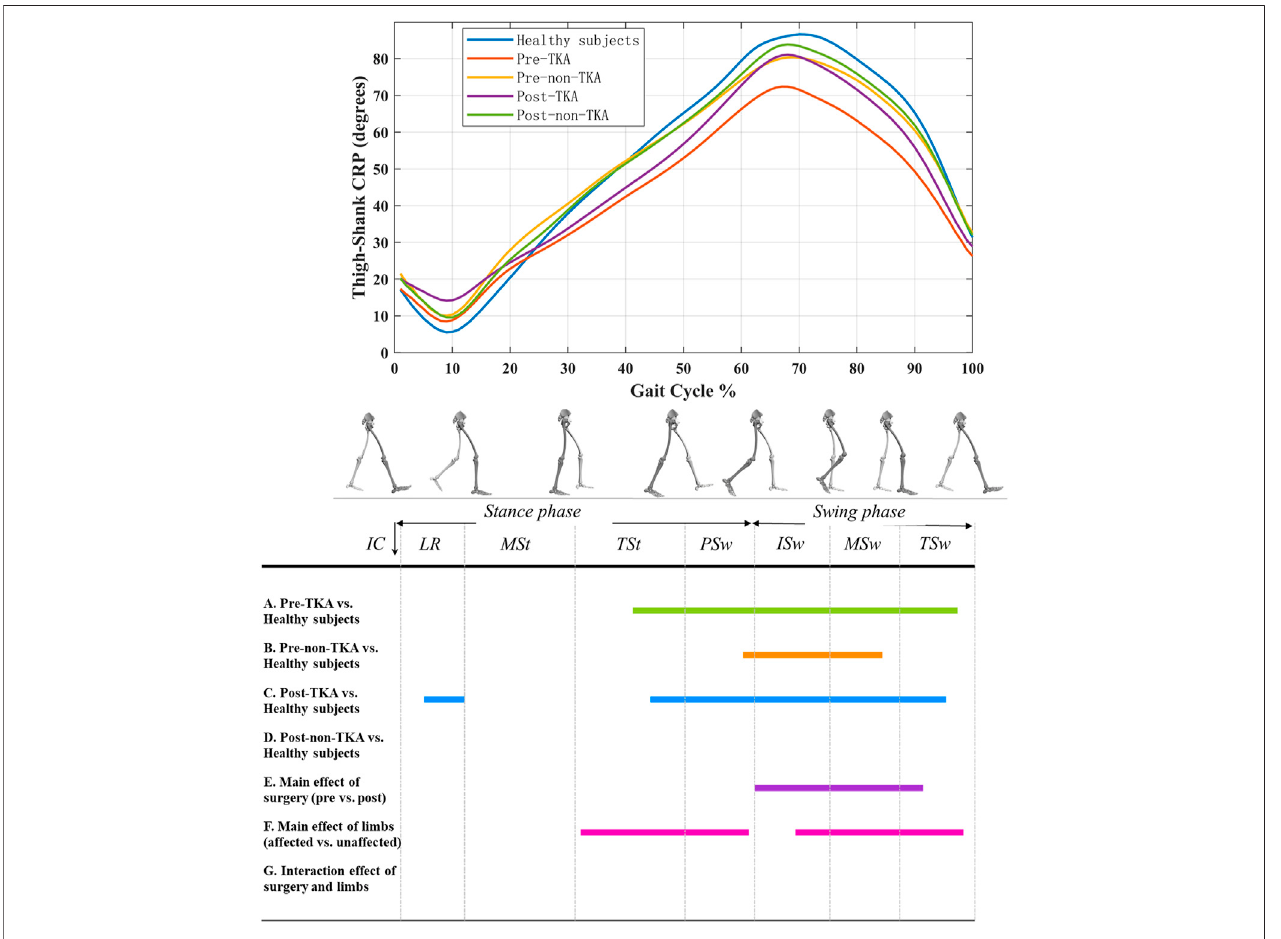
FIGURE 1 | Thigh-shank CRP curves in patients before and after TKA and healthy subjects. A positive value indicates that thigh leads over shank, and a negative value indicates that shank leads over thigh. The colored lines in A ~ G indicate that there are signi fi cant differences during this period when the two are compared.